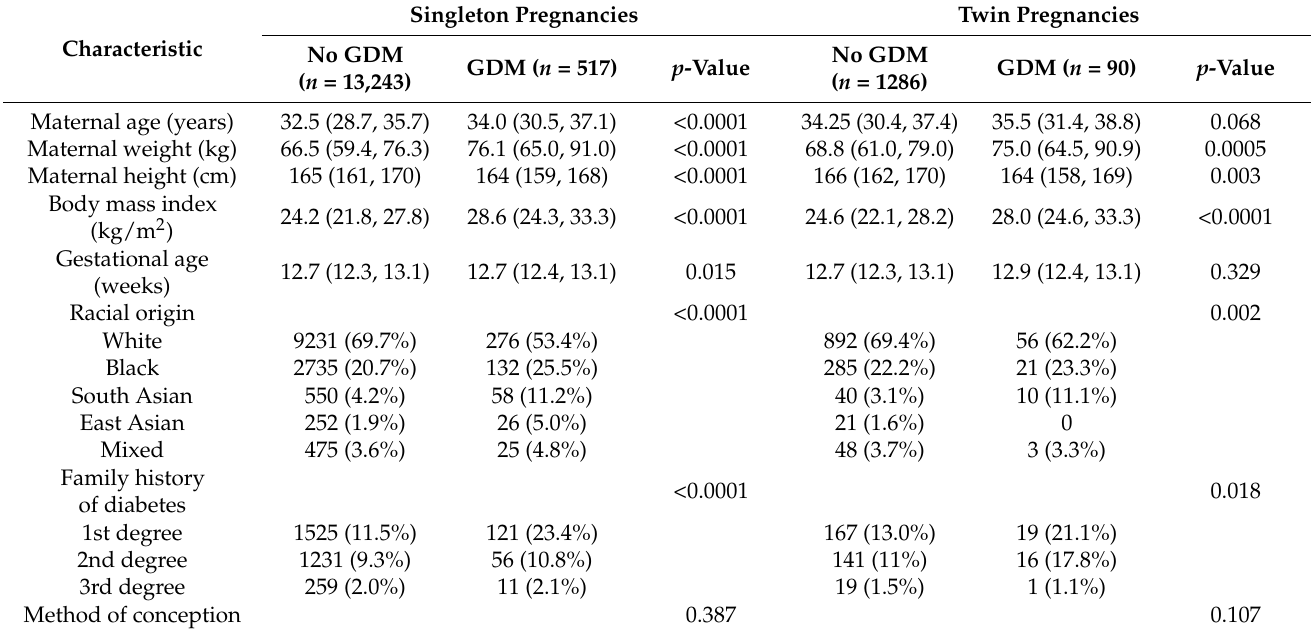
Table 1. Demographic and pregnancy characteristics of the study